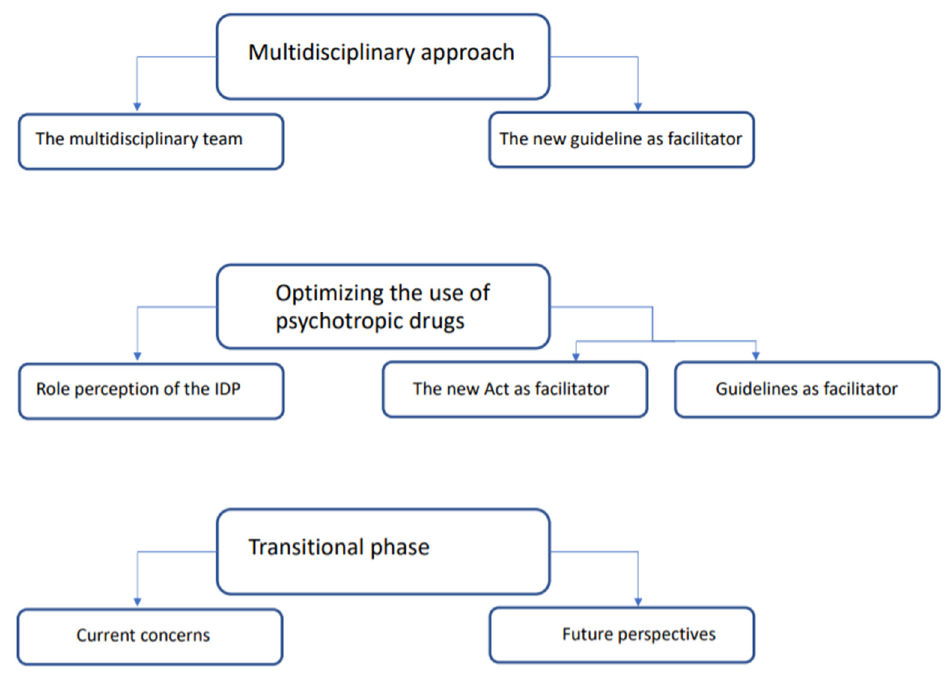
Figure 2. The three major themes and subthemes.